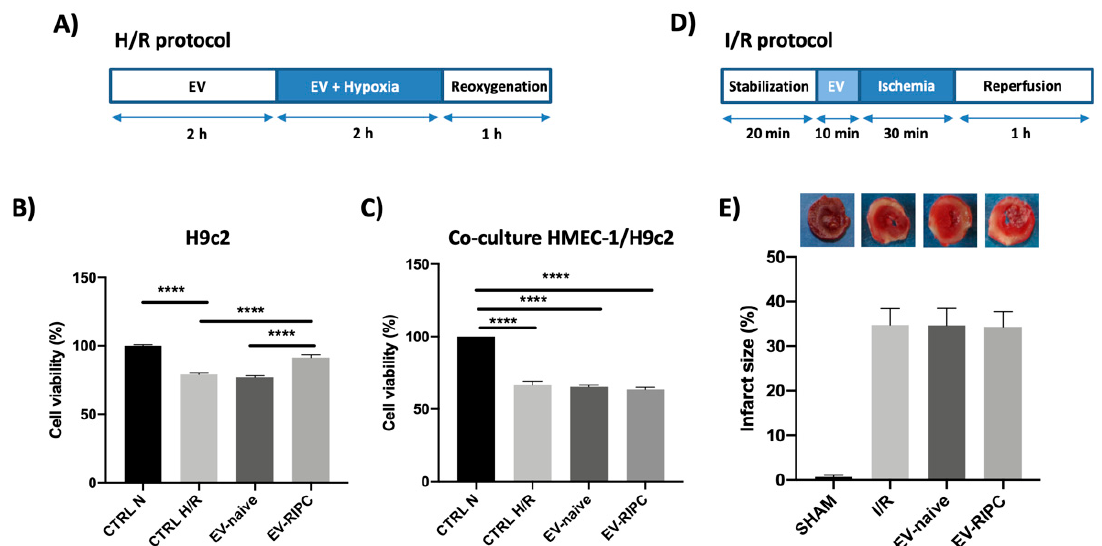
Figure 3. Impact of EVs in vitro and ex vivo. ( A ) Timeline of in vitro H/R protocol. H9c2 or co-culture of H9c2 and HMEC-1 were subjected to 2 h of hypoxia, followed by 1 h of reoxygenation. EVs were infused for 2 h before hypoxia and during hypoxia. ( B ) Cell viability on H9c2 cells subjected to H/R protocol, after treatment with EV-naive or EV-RIPC; data were normalized to the mean value of normoxic control. (**** p < 0.0001 CTRL N vs. CTRL H/R; **** p < 0.0001 CTRL H/R vs. EV-RIPC; **** p < 0.0001 EV-naive vs. EV-RIPC). ( C ) Cell viability on H9c2 co-cultured with HMEC-1 in trans-well assay; data were normalized to the mean value of normoxic control. ( D ) Timeline of ex vivo I/R protocol. The hearts were subjected to 30 min of global, normothermic ischemia, followed by 60 min of reperfusion. EVs were infused for 10 min before ischemia. ( E ) Infarct size in isolated rat hearts treated as indicated. The necrotic mass was measured at the end of reperfusion and reported as percentage of the left ventricle mass (LV; % IS/LV).